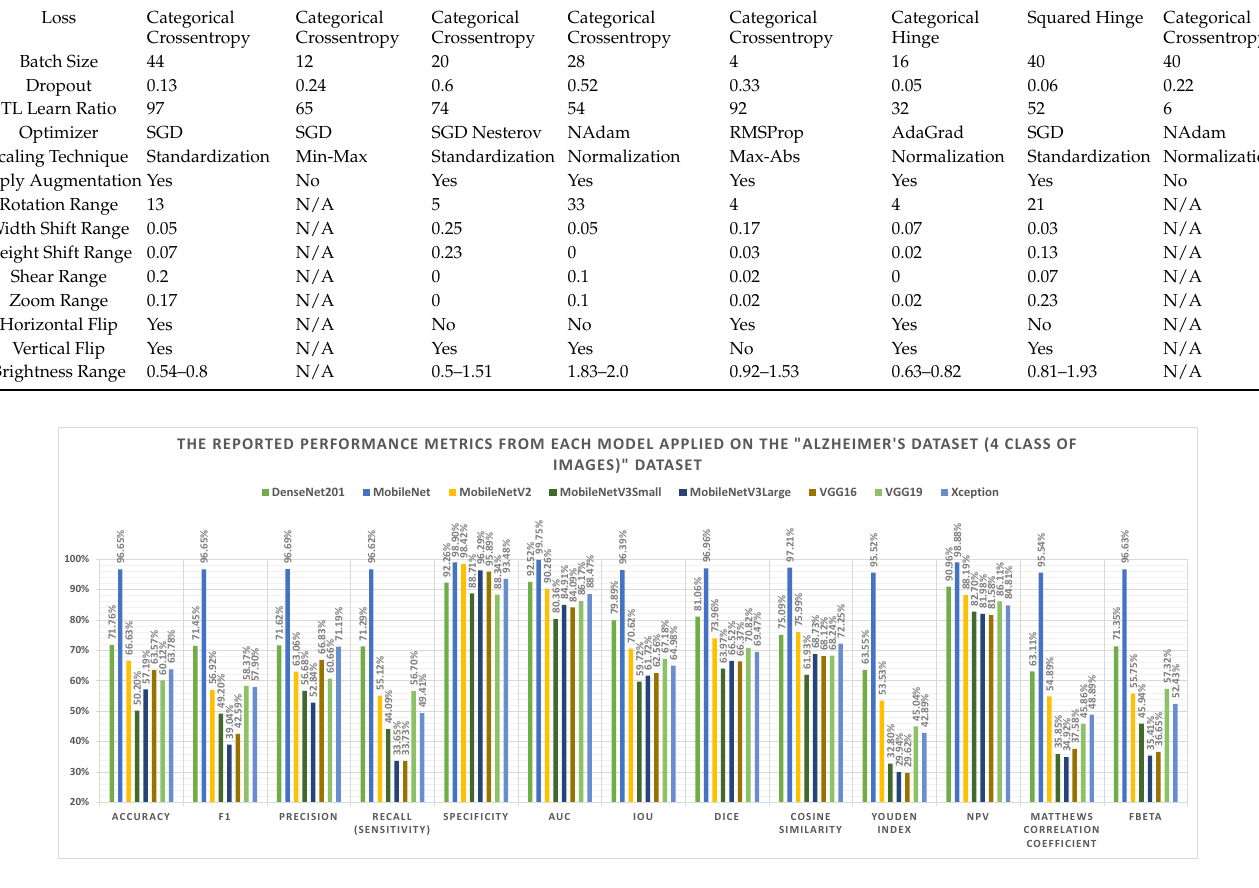
Figure 8. Graphical summary of the performance metrics of the “Alzheimer’s Dataset (4 class of Images)” dataset.